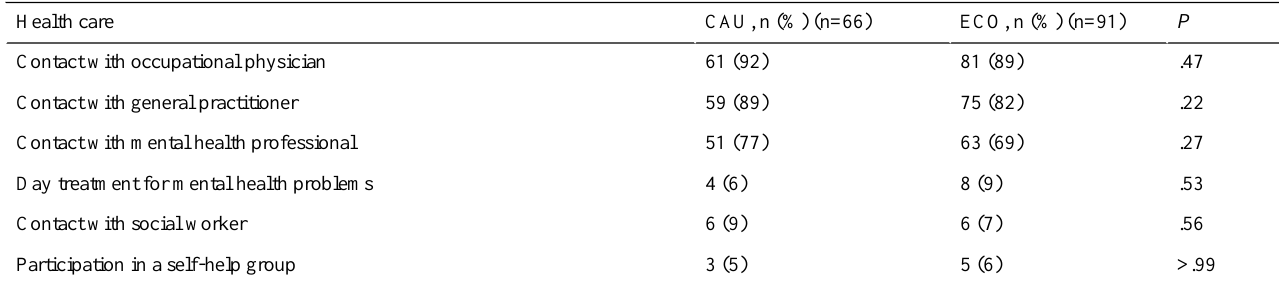
Table 4. Health care utilization within 12 months after